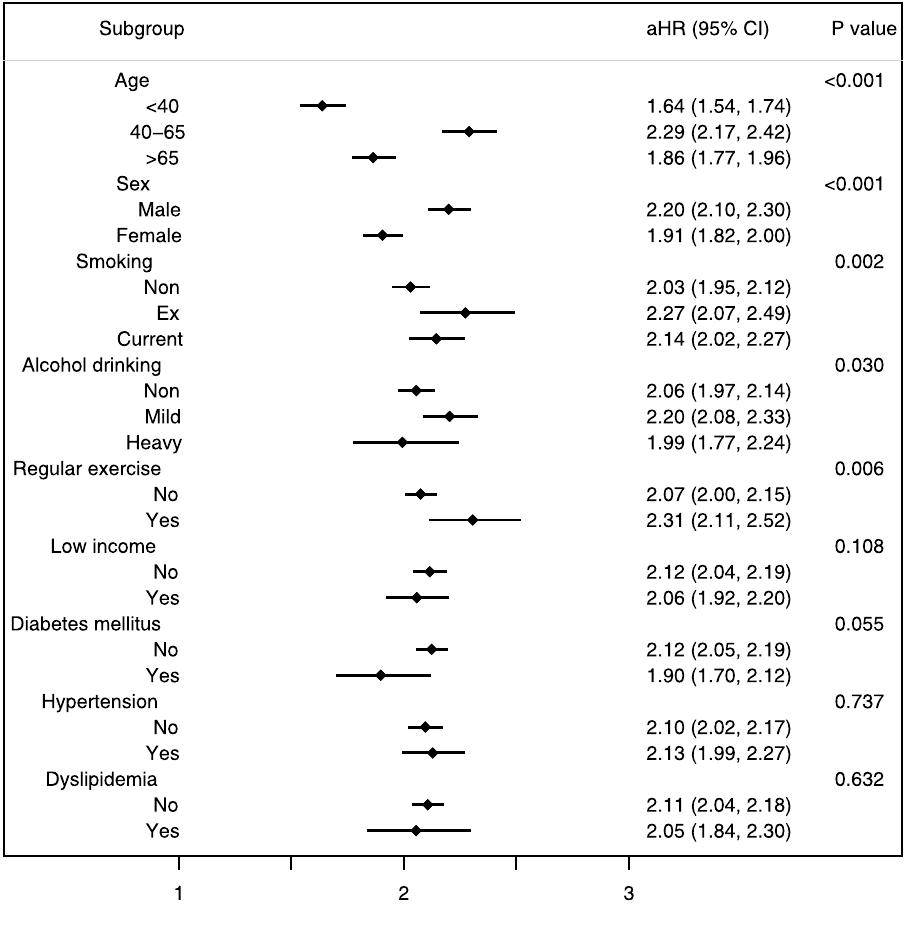
Figure 3. Subgroup analysis of adjusted hazard ratio for TB in the underweight